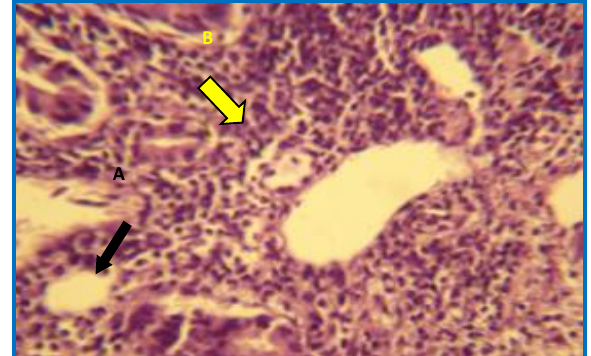
Figure, 8: Shows atrophy of epithelial mucosa which become rounded (A), with neutrophils infiltration in subepithelial layer (B). Group B, seven days post operation (H and E 40 X).